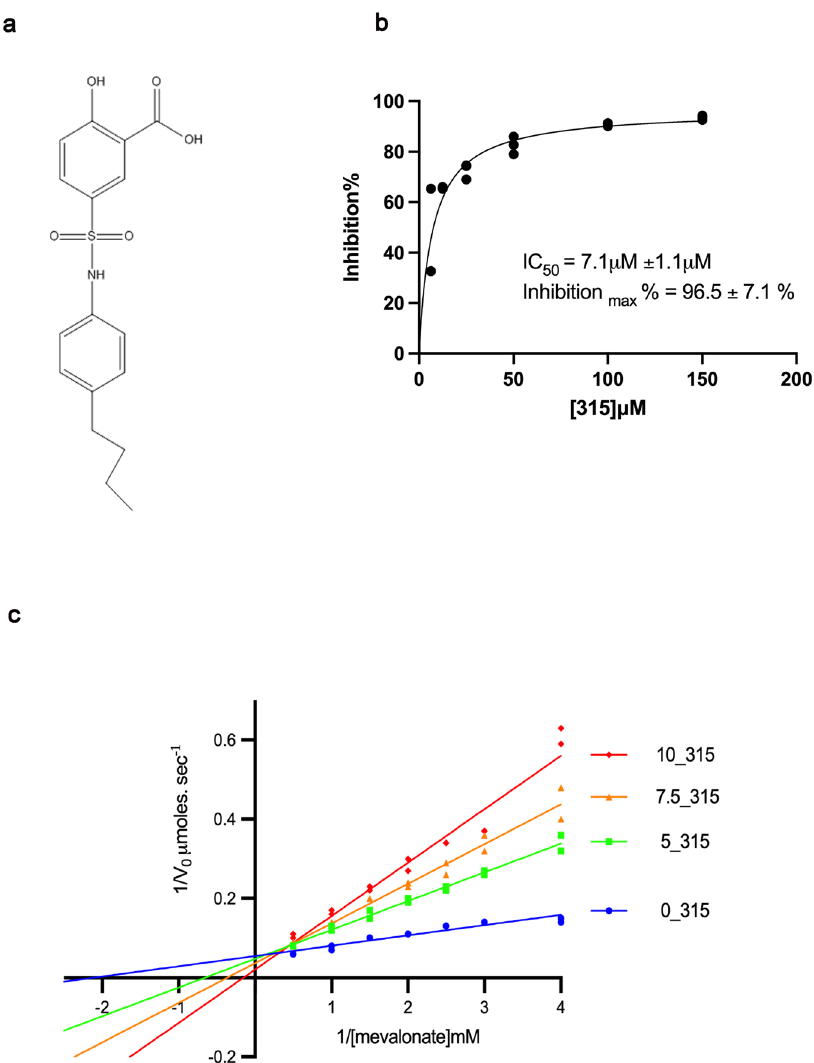
Fig. 4 315 is a competitive inhibitor of efHMGR. a Chemical structure of 315 (Chembridge2 ID 7828315): 5-{[(4-butylphenyl) amino] sulfonyl}-2- hydroxybenzoic acid. This compound is composed of a hydrophobic 4-butylphenyl group linked to the 2-hydroxy benzoic acid via an amino and a sulfonyl group. b Dose-response curves of 315 against E. faecalis HMG-CoA reductase. The IC 50 value was estimated by Michaelis-Menten fi tting of the inhibition % vs. inhibitor concentration data. Assays were conducted in triplicates c A Lineweaver plot shows that 315 is a competitive inhibitor of efHMGR. An analysis of this plot indicates that 315 inhibits the conversion of mevalonate to HMG-CoA with a Ki of 2 μ M. Assays were conducted in duplicates and in the presence of 0, 5, 7.5 and 10 μ M of 315 under otherwise standard conditions. Both datasets were analyzed by Graphpad Prism 9.0 and presented as individual data